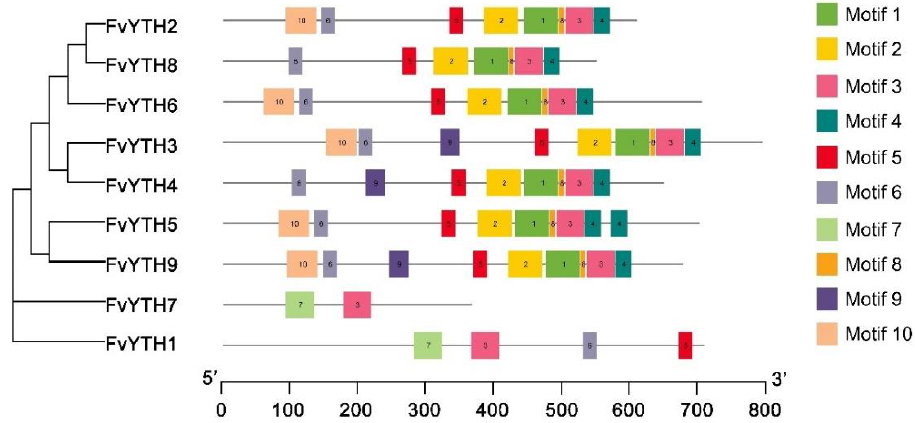
Figure 3. Distributions of conserved motifs in FvYTH proteins. Ten putative motifs are indicated in different colored boxes.